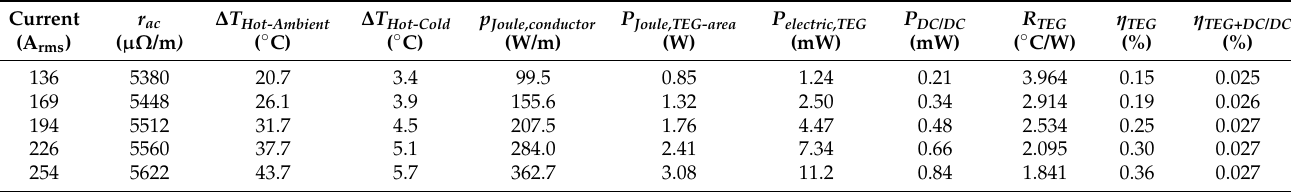
Table 6. Steady-state performance results of the entire system.